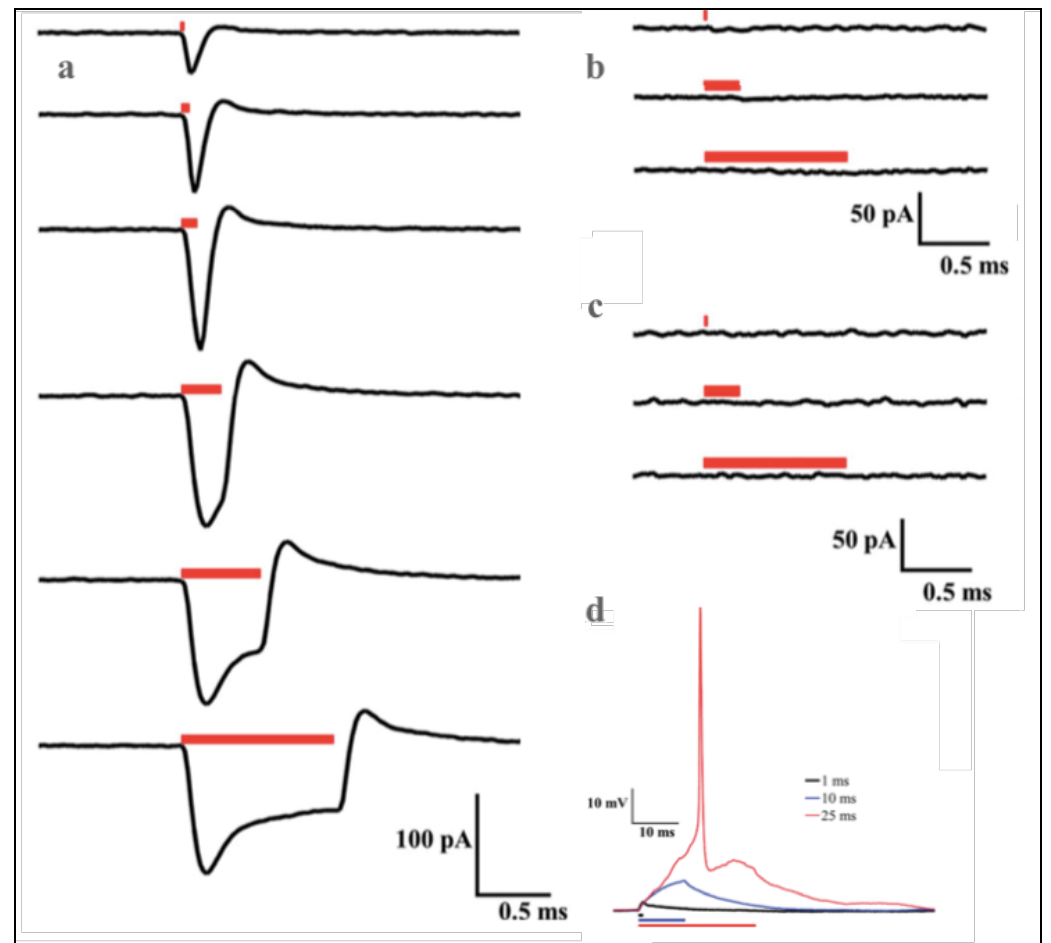
Figure 6. Representative averaged voltage-clamp data from ( a ) an NR-AN responding to laser pulses delivered over di ff erent durations (from top to bottom: 0.025, 0.05, 0.1, 0.25, 0.5, and 1 ms); ( b ) NS-AN receiving laser pulses for, from top to bottom, 0.025, 0.25, and 1 ms; and ( c ) a control neuron under similar conditions to ( b ). Bars indicate the timing and duration of laser pulses. All neurons were held at − 73 mV. ( d ) action potential of AuNRs-neuron indirectly caused by one 25-ms laser pulse while subthreshold neuron potentials were being record at 1 and 10 ms laser pulses. Reproduced with permission from [23]. John Wiley and Sons, 2014.